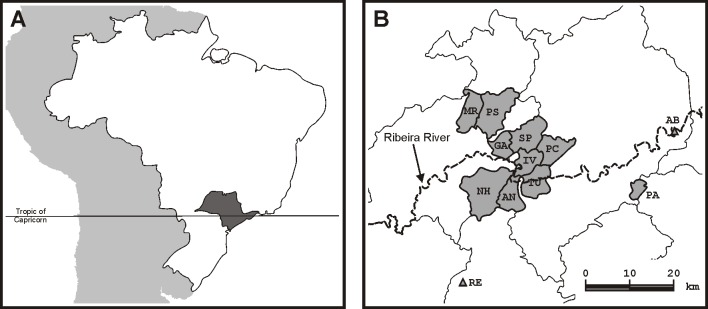
Location of quilombo communities.(A) State of São Paulo (gray) within Brazilian territory in South America. (B) Location of quilombo communities. AB, Abobral; AN, André Lopes; GA, Galvão; IV, Ivaporanduva; MR, Maria Rosa; NH, Nhunguara; PA, Poça; PC, Pedro Cubas; PS, Pilões; RE, Reginaldo; SP, São Pedro; TU, Sapatu. (Adapted from Lemes et al. [1]).